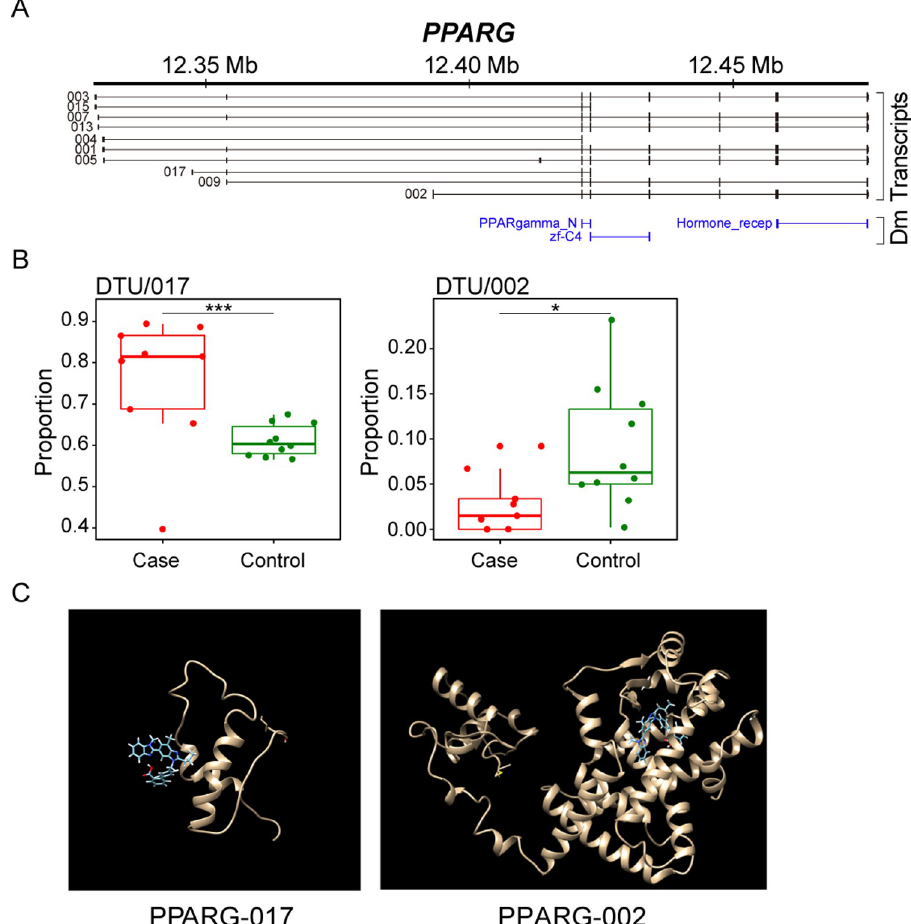
Fig 6. Aberrant isoform usage and drug-protein interactions of PPARG in COVID-19. (A) Transcript isoforms and domains of PPARG on human GRCh37/hg19. PPARG-002 is the canonical transcript. (B) Bar plots for changes in transcript usage for PPARG-017 and PPARG-002. � posterior probability > 0.5; �� posterior probability > 0.7; ��� posterior probability > 0.9. (C) Telmisartan-protein interactions in PPARG-017 and PPARG-002.